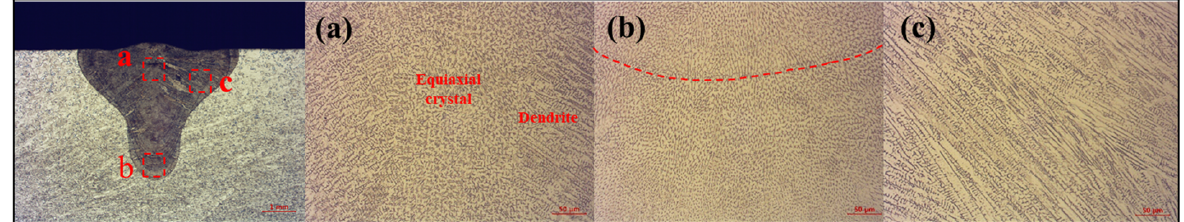
Figure 5. Optical micrographs showing microstructure in weld area cross section for specimen prepared via underwater laser welding with a laser power of 2 kW. The three right ‐ most panels show expanded views of areas outlined by dashed red lines in the left ‐ most panel. ( a ) enlarged a, ( b ) enlarged b, ( c ) enlarged c.